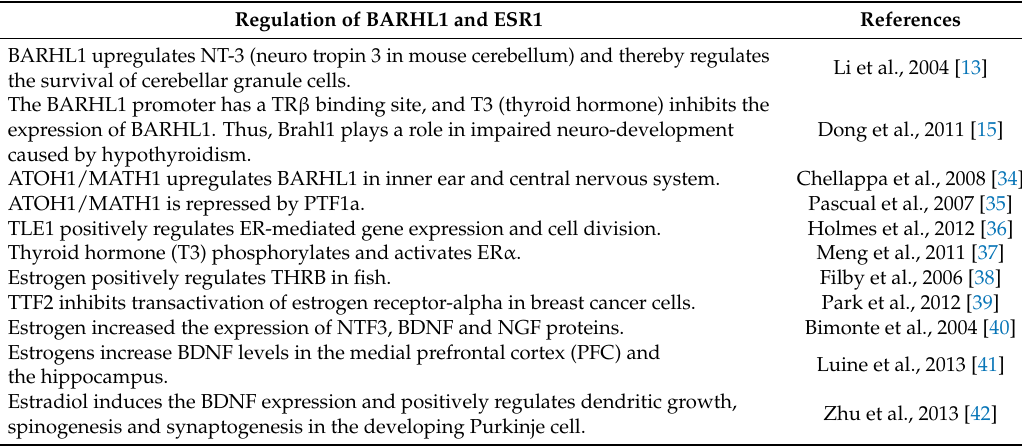
Table 3. Regulation of BARHL1 and Estrogen Receptor 1 (ESR1) as evidenced from the literature. Regulation of BARHL1 and